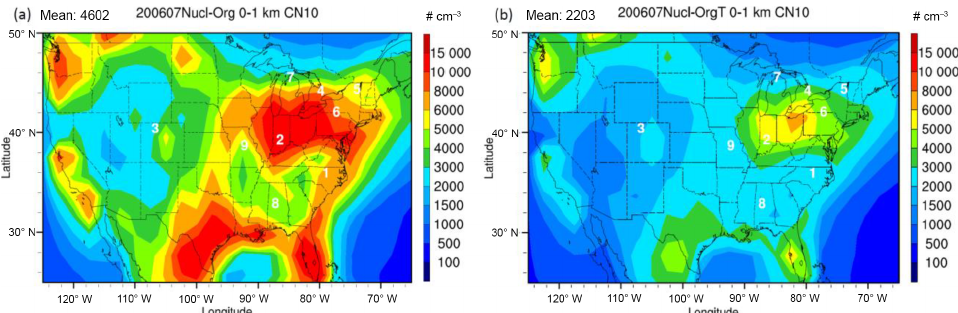
Figure 5. The horizontal distributions of monthly mean CN10 in the boundary layer (0–1km above surface) in July 2006 based on two organics-mediated nucleation schemes: (a) J Nucl-Org and (b) J Nucl-OrgT . The locations of nine forest sites where observed particle size distribution measurements have been taken and used for comparison in Yu et al. (2015).